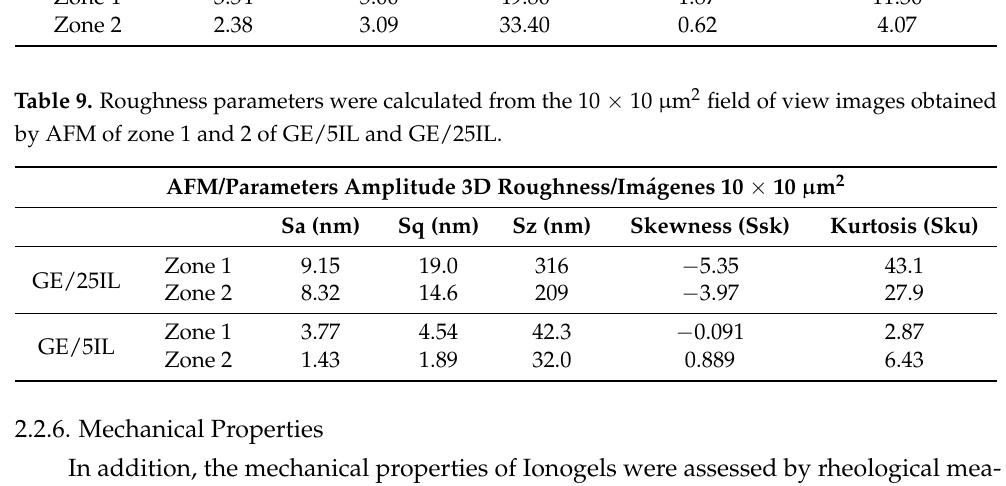
Gels 2022 , 8 , x FOR PEER REVIEW